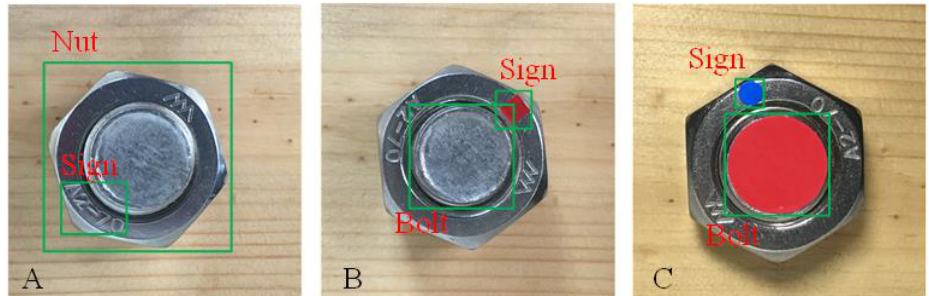
Figure 3. Collected images of the three schemes ( A – C ).